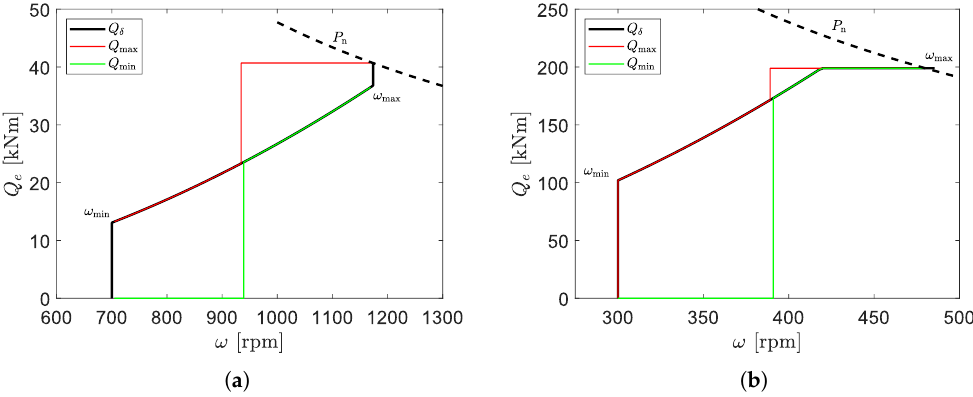
Figure 3. Generator speed-torque curves of NREL 5-MW ( a ) and DTU 10-MW ( b ) reference